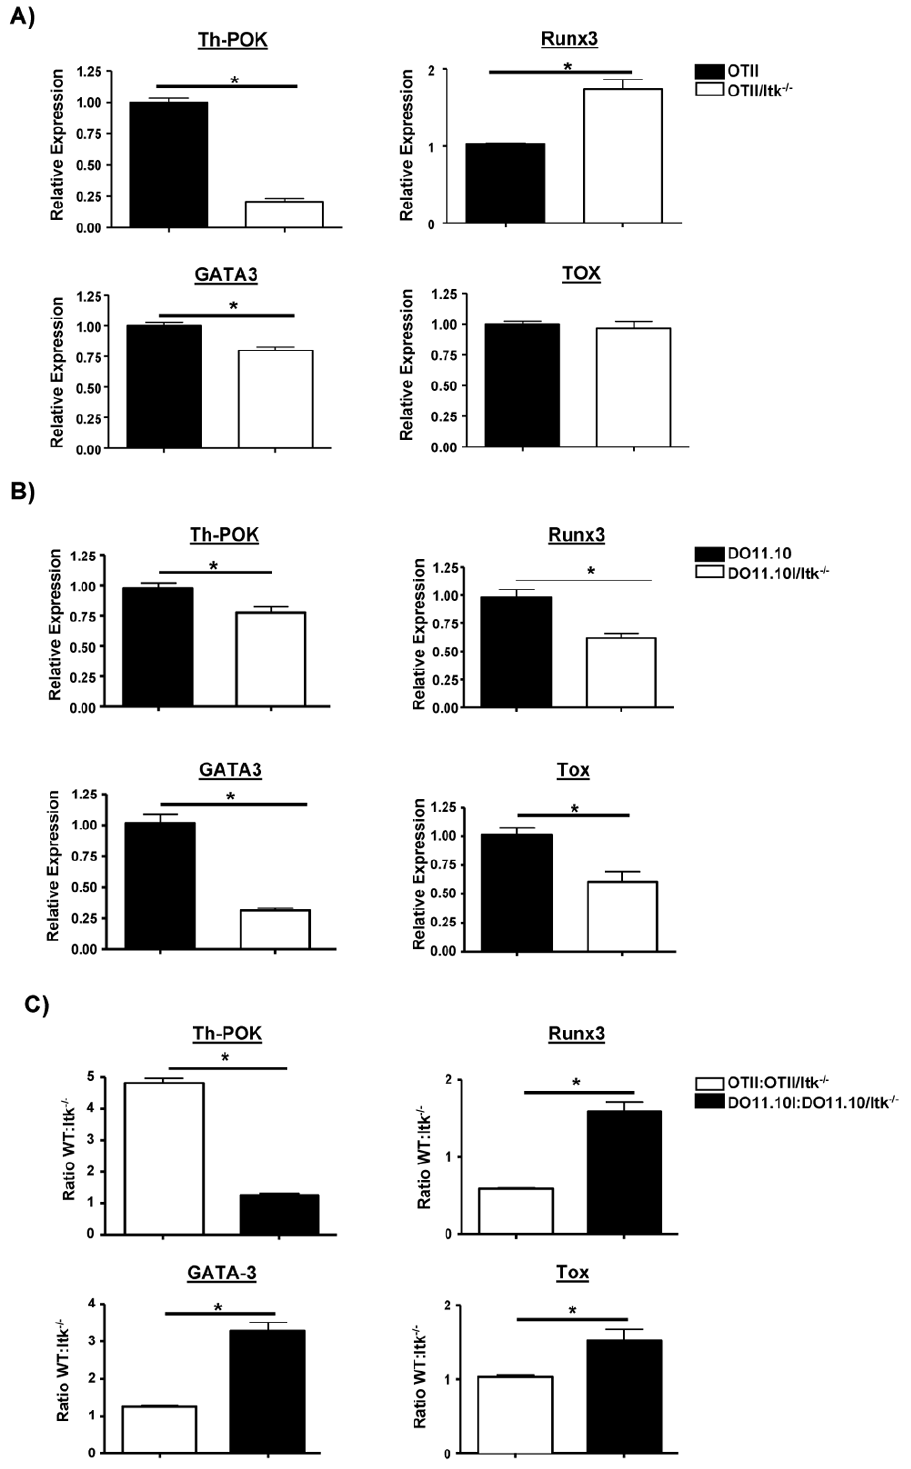
Figure 9. Itk mediated signals regulate the expression of the CD4 lineage commitment factor Th-POK. ( A ) Quantitative real-time RT-PCR for Th-POK, TOX, Runx3 and GATA3 in sorted transgenic TCR hi DP thymocytes from OT-II and OT-II/Itk 2 / 2 mice. Data are corrected for GAPDH expression and expressed as fold over mRNA of the transgenic TCR hi DP derived from OT-II mice, which was set at 1 (n=3, *p , 0.05). The experiment was repeated 2X with the same results. ( B ) Quantitative real-time RT-PCR for Th-POK, TOX, Runx3 and GATA3 in sorted transgenic TCR hi DP thymocytes from DO11.10 and DO11.10/Itk 2 / 2 mice Data are corrected for GAPDH expression and expressed as fold over mRNA of the transgenic TCR hi DP derived from DO11.10 mice, which was set at 1 (n=3, *p , 0.05). The experiment was repeated 2X with the same results. ( C ) Data used to generate (A) and (B) were rescaled to generate ratios of either OT-II:OTII/Itk 2 / 2 or DO11.10:DO11.10/Itk 2 / 2 mRNA expression levels for Th-POK, Runx3, GATA3 and TOX.